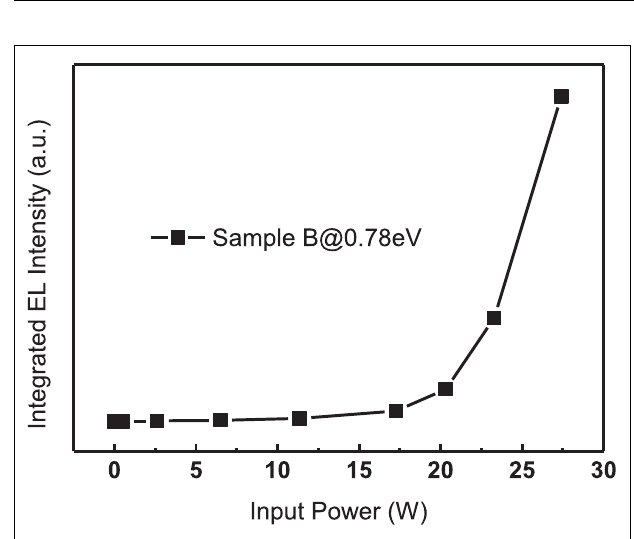
dislocation-related bands in the low-temperature PL